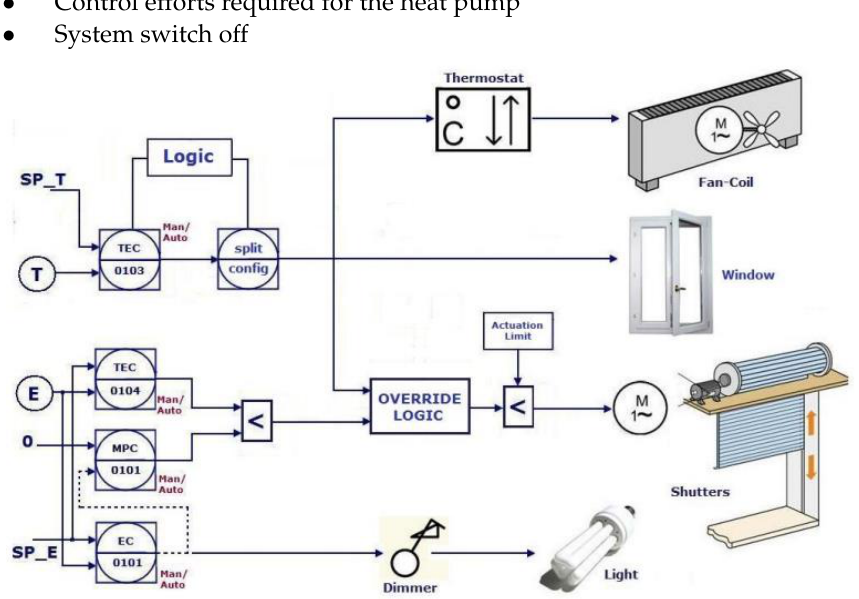
Figure 8. Architecture of the initial control system.